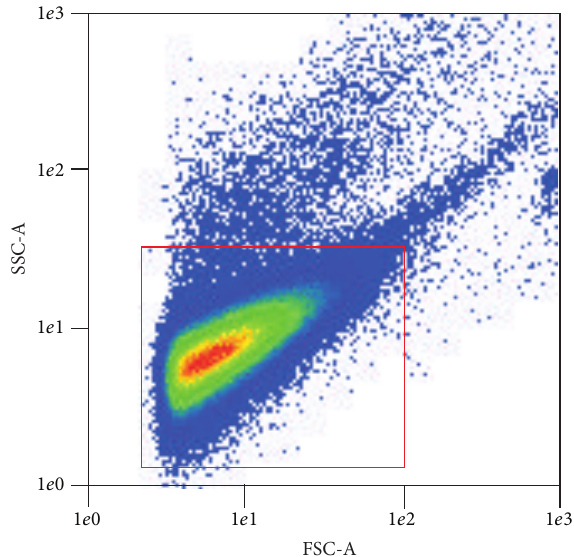
Figure 1: Density plot (forward scattered light FSC-A versus side scattered light SSC-A) representing extracellular vesicles (EVs) iso- lated from a sample of blood incubated with lidocaine/epinephrine (L/E) [39]. The region within the red rectangle estimates events due to